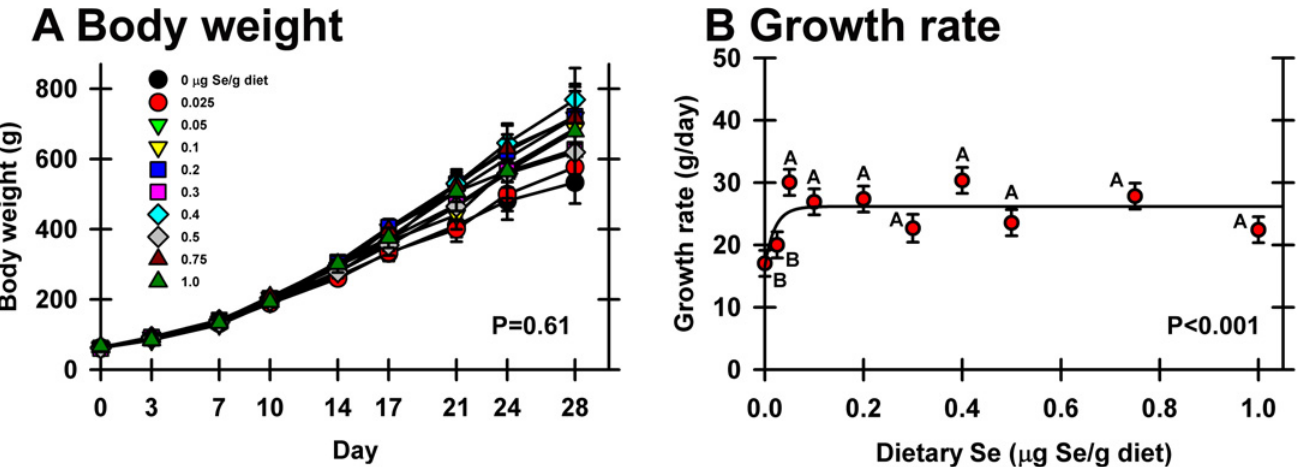
Fig 1. Effect of dietary Se on growth of young male poults. A. Body weights of day-old male poults supplemented with graded levels of dietary Se for 28 d (n = 5/treatment) and weighed biweekly. B. Daily weight gain of poults over days 7 – 28, expressed as g/day. Values are mean ± SEM. Means without a common letter are significantly different ( P <